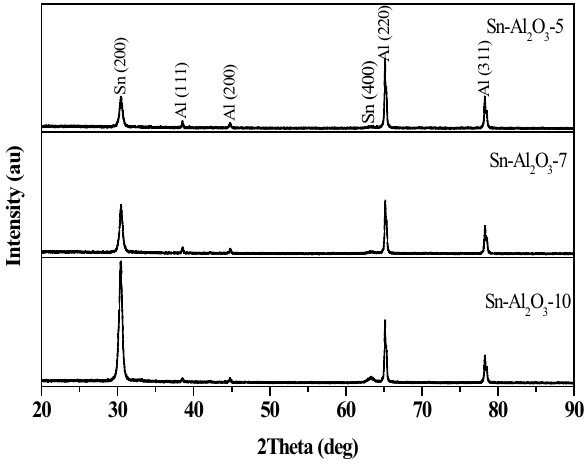
Fig. 1 The XRD patterns of the Sn–Al